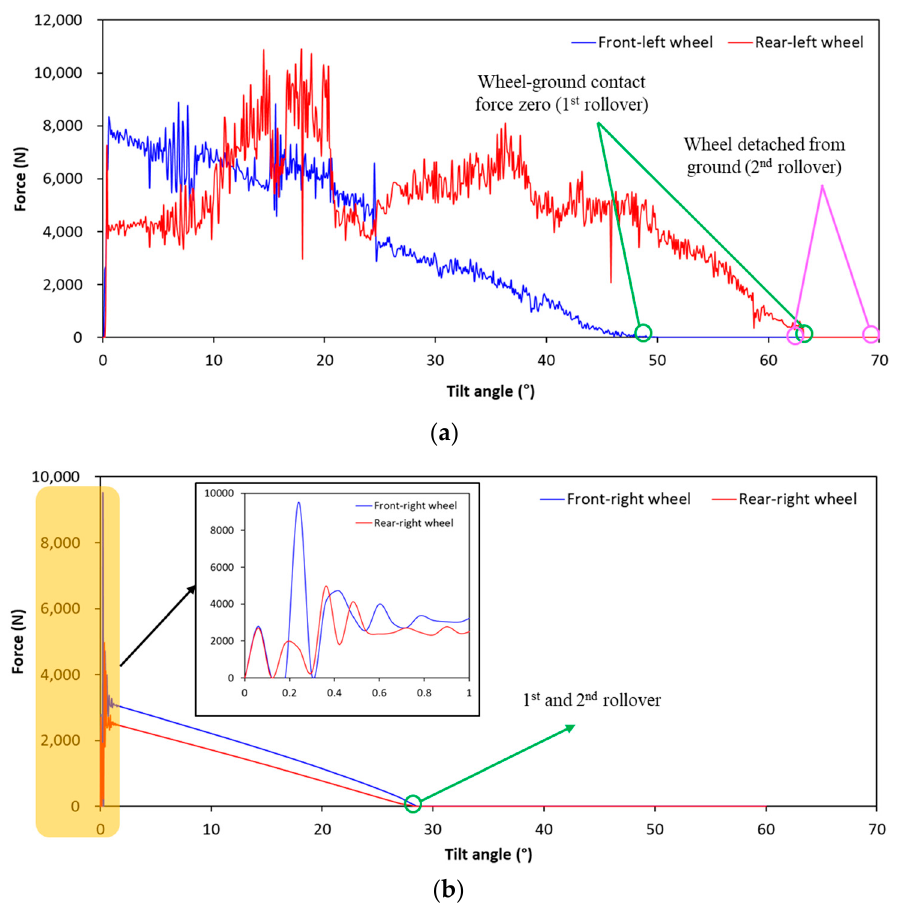
Figure 8. The rollover angles and contact force of the radish harvester: ( a ) first and second rollover angles on the deflection angle of 0 ° , and ( b ) first and second rollover angles on the deflection angle of 180 °.